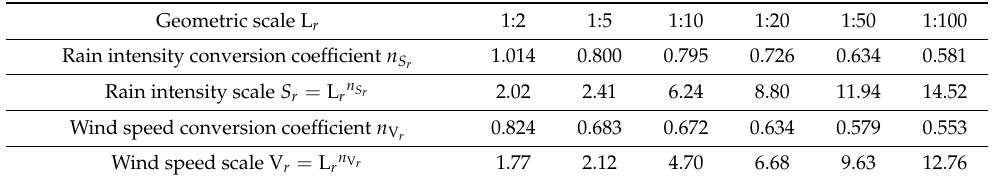
Table 2. Atomization wind speed and rainfall conversion coefficient n under different geometric scale conditions.